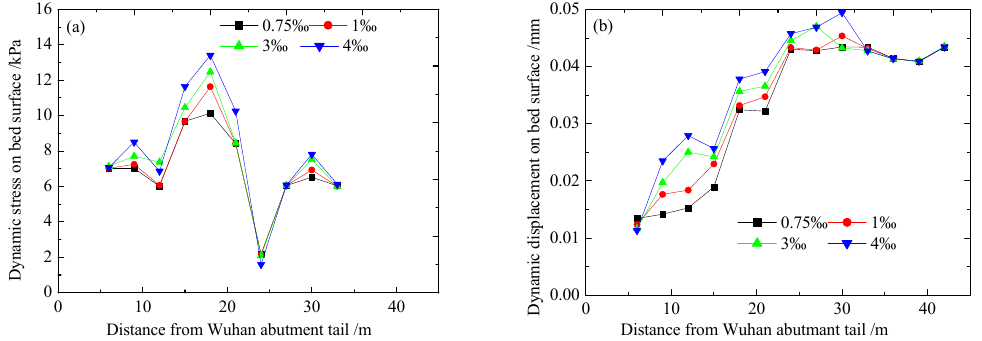
Figure 10. Effect of angle change on dynamic response of subgrade surface layer: ( a ) dynamic stress; ( b ) dynamic displacement.